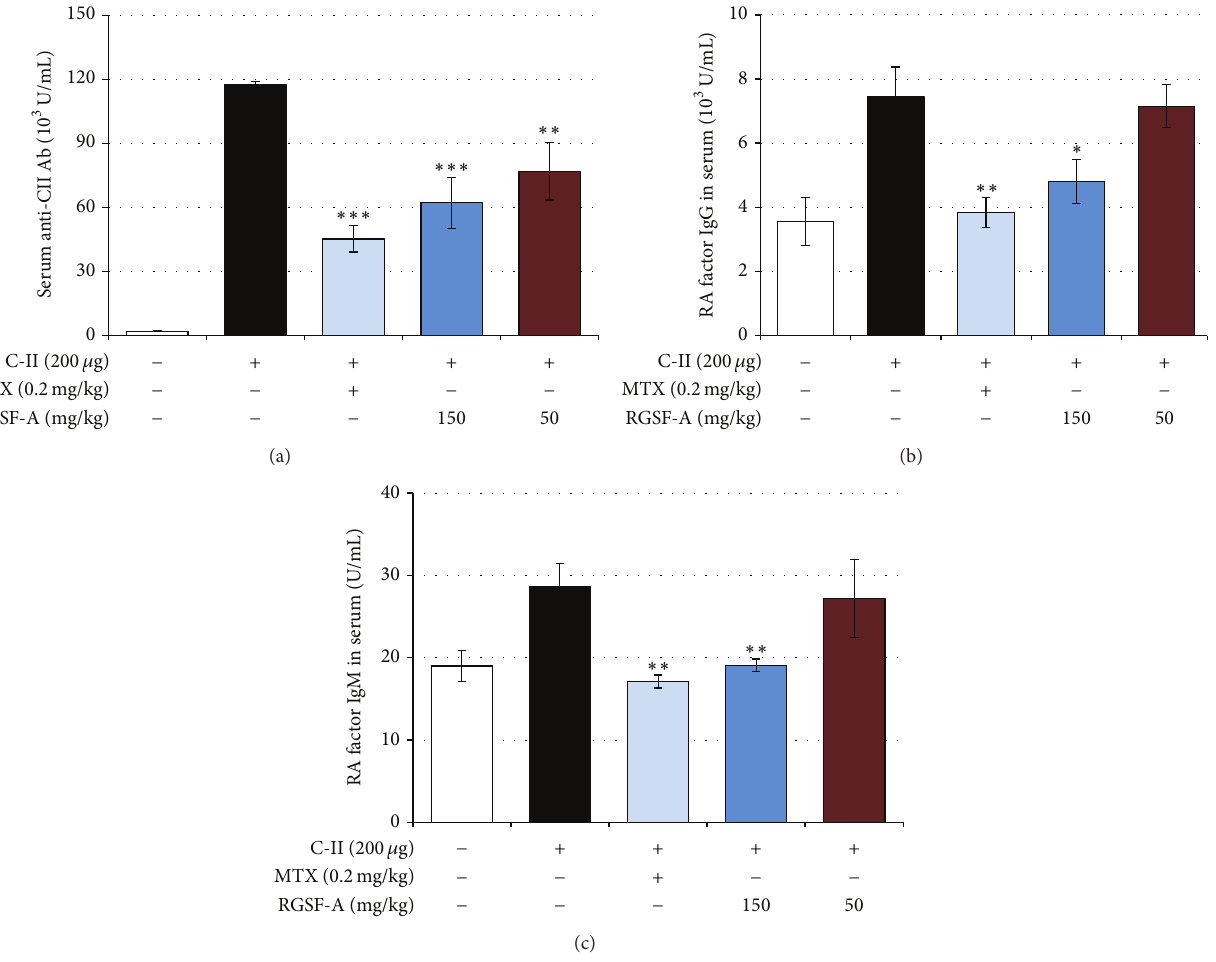
Figure 5: RGSF-A modulates CIA anti-CII IgG and rheumatoid factor (RF) serum antibody levels in mice. (a) Total anti-CII IgG antibody level was measured by enzyme-linked immunosorbent assay (ELISA) in mice treated with RGSF-A, MTX, or vehicle. The serum levels of RF IgG (b) and RF IgM (c) were determined by ELISA. ∗ 𝑃 < 0.05 , ∗∗ 𝑃 < 0.01 , and ∗∗∗ 𝑃 < 0.001 as compared with vehicle treatment; 𝑛 = 6 for each